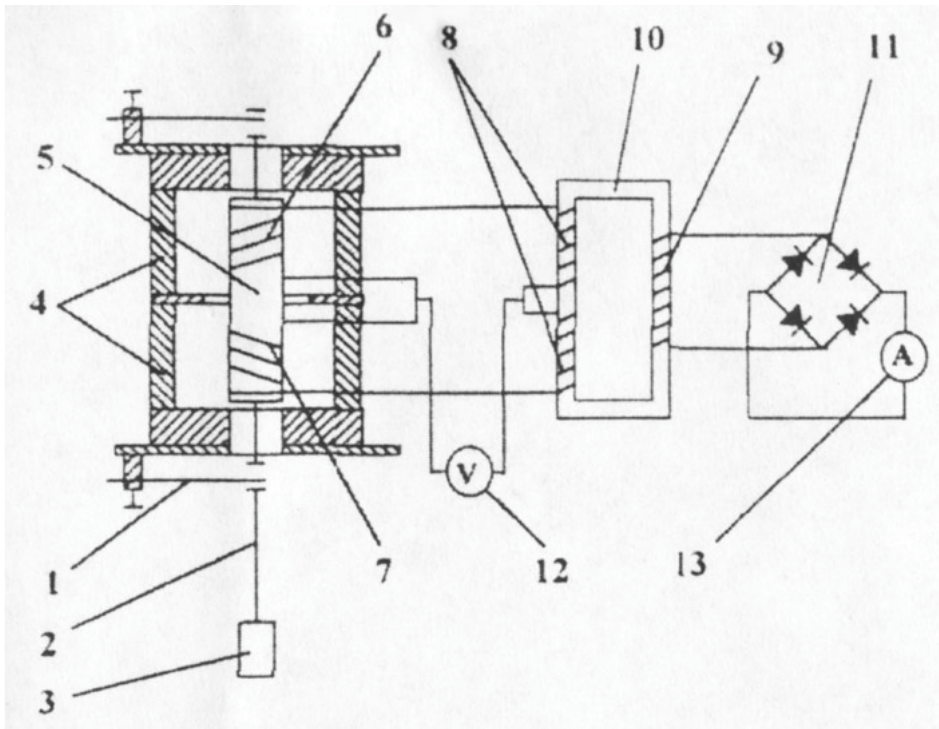
Figure 3. Diagram of the electro-vibratory viscometer. 1— fl at springs; 2—molybdenum rod; 3— molybdenum probe; 4—permanent magnets; mild steel core; 6, 7—coils; 8—primary windings, 9— secondary windings; 10—di ff erential transformer; 11—recovery bridge; 12—millivoltmeter; 13— ampermeter.